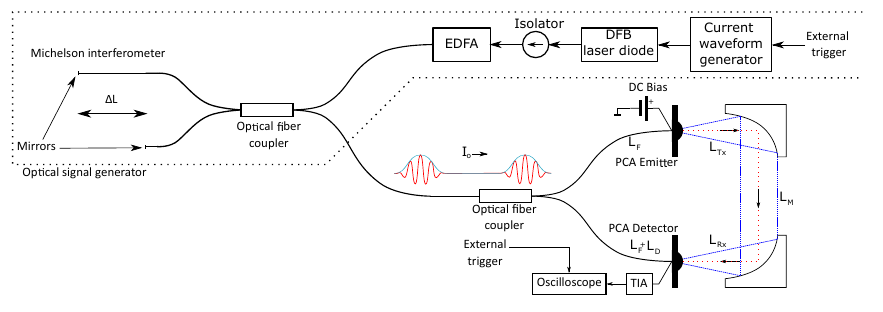
Figure 3. Proposed QCW-THz system’s